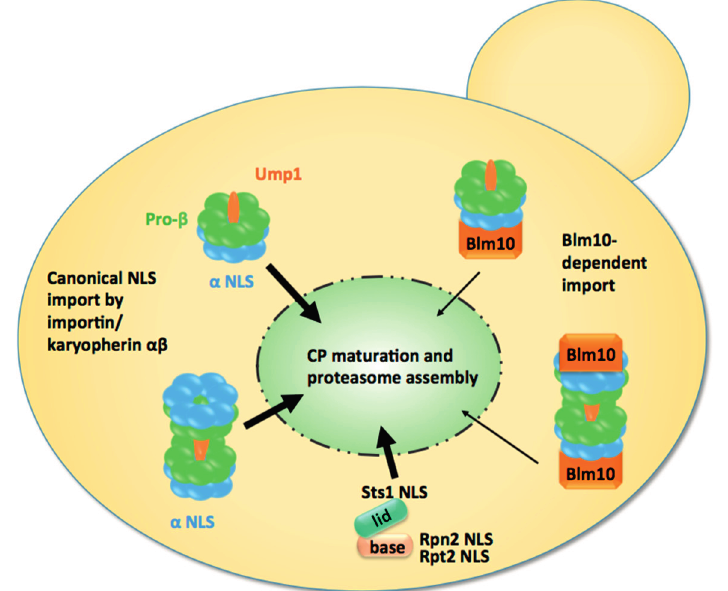
Figure 2. Model of nuclear import of CP precursor complexes and RP modules in proliferating yeast cells. Either the half-CP precursor or the pre-holo-CP, as indicated by the presence of immature pro- β subunits and the maturation factor Ump1, serve as the import cargo. They are mainly transported by the canonical pathway using classical nuclear localisation sequences (NLS) within α subunits and the receptor importin/karyopherin αβ . Blm10 provides an alternative import pathway. Modules of RP base and lid are imported by the classical pathway using NLS within Rpt2, Rpn2, and Stst1. Ump1 and Sts1 are short-lived and degraded with the completion of proteasome maturation and the assembly of holo-enzymes in the